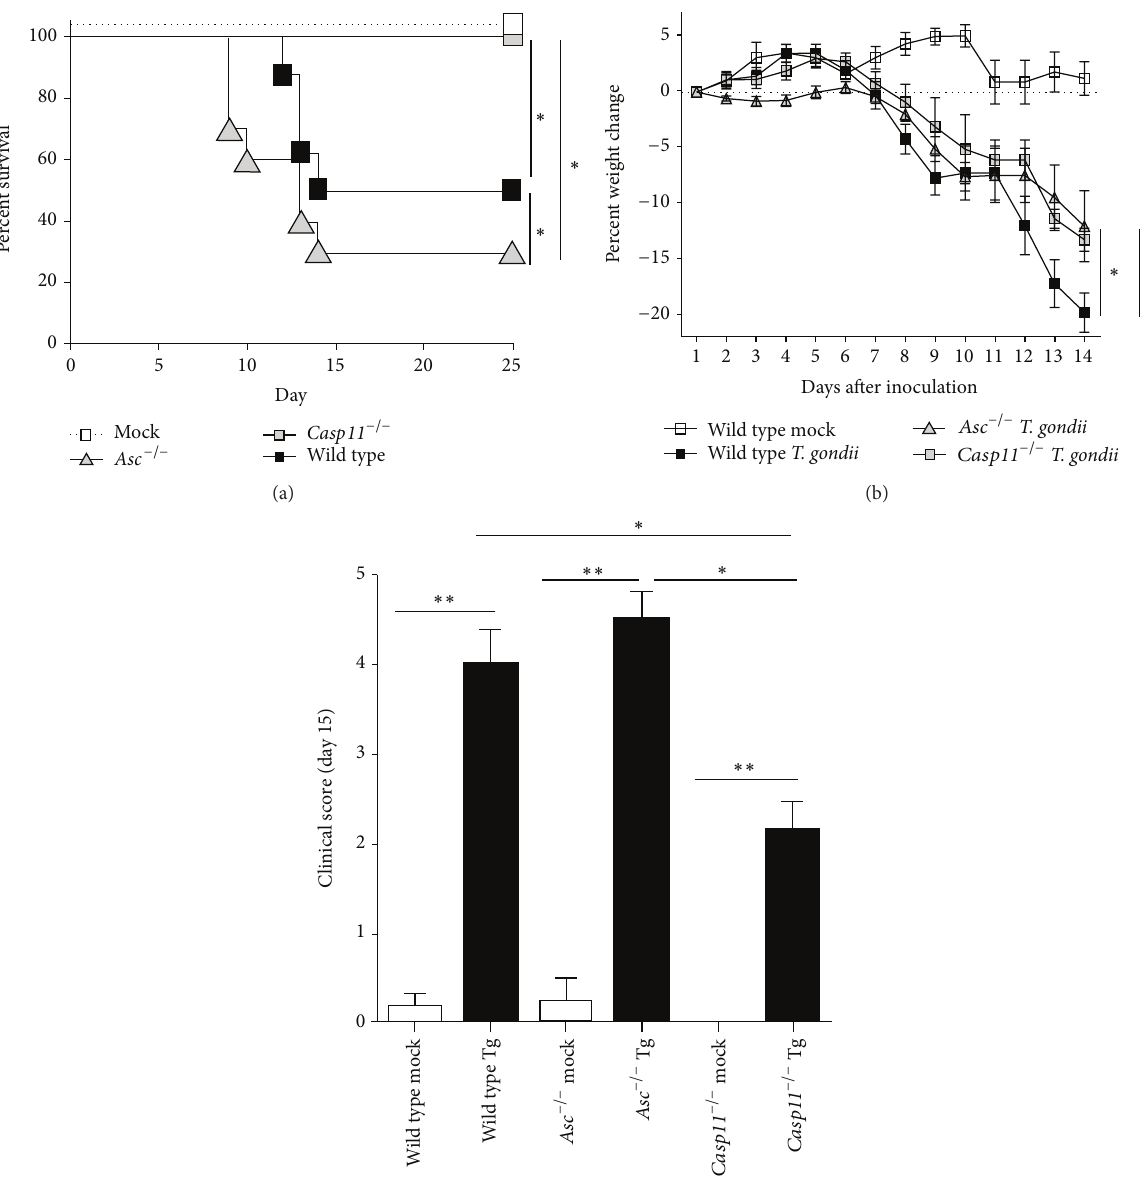
Figure 2: Casp11 −/− mice exhibit reduced susceptibility to Toxoplasma gondii infection. Wild type, Casp11 −/− , and Asc −/− mice were infected with 1,000 Toxoplasma gondii Me49 tachyzoites via i.p. administration. Morbidity and mortality were monitored daily. (a) Kaplan-Meier plot of WT, Asc −/− , and Casp11 −/− mice survival. Mice were considered moribund when weight loss was sustained at or below − 15% from baseline and/or clinical parameters necessitated euthanasia. (b) Weight loss was evaluated daily and the percent change from baseline for each animal was calculated. Data shown reflect 1–14 days after inoculation due to the significantly reduced survival of the wild type and Asc −/− mice at day 15. (c) Casp11 −/− mice demonstrate significantly attenuated clinical parameters associated with disease progression. The clinical score is a composite of scores associated with weight loss, clinical condition, and behavior. ∗ 𝑝 < 0.05 . Wild type mock, 𝑛 = 9 ; Asc −/− mock, 𝑛 = 9 ; Casp11 −/− mock, 𝑛 = 6 ; wild type Tg, 𝑛 = 18 ; Asc −/− Tg, 𝑛 = 18 ; Casp11 −/− Tg, 𝑛 = 13 . Data shown are representative of 3 independent